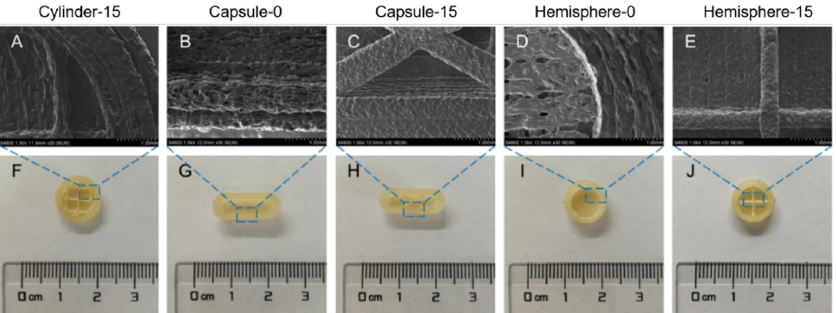
Figure 5. SEM section view ( A – E ) and corresponding photographs ( F – J ) of the formulations.